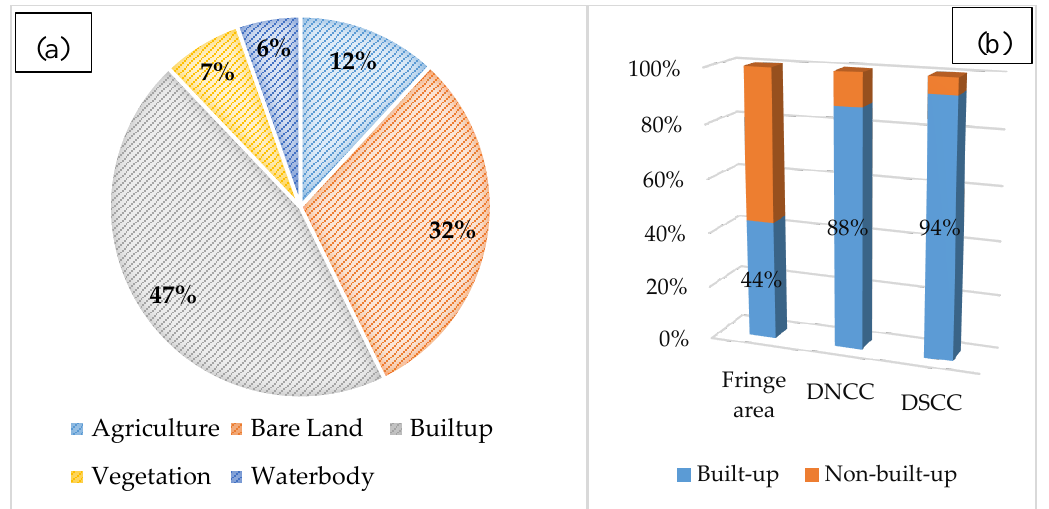
Figure 11. ( a ) Pie chart with the percentage of different land use land cover (LULC) classes and ( b ) built-up ratio shared by the Dhaka Metropolitan Area (DMA). Table 4. Landscape